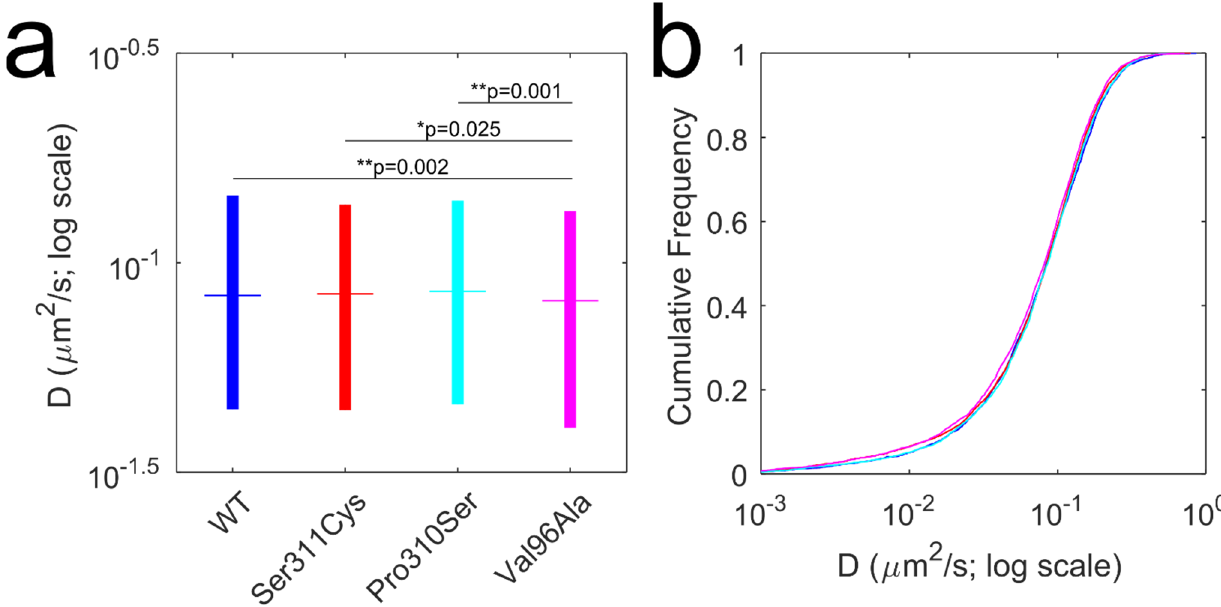
Figure 3. Comparison of the Qdot-tagged D2L receptor variant lateral mobility. ( a ) C–W D 2-5 (no gaps) diffusion coeffi- cients were determined for four D2L variants tracked and the box plots with 25–75% IQR shown here. The